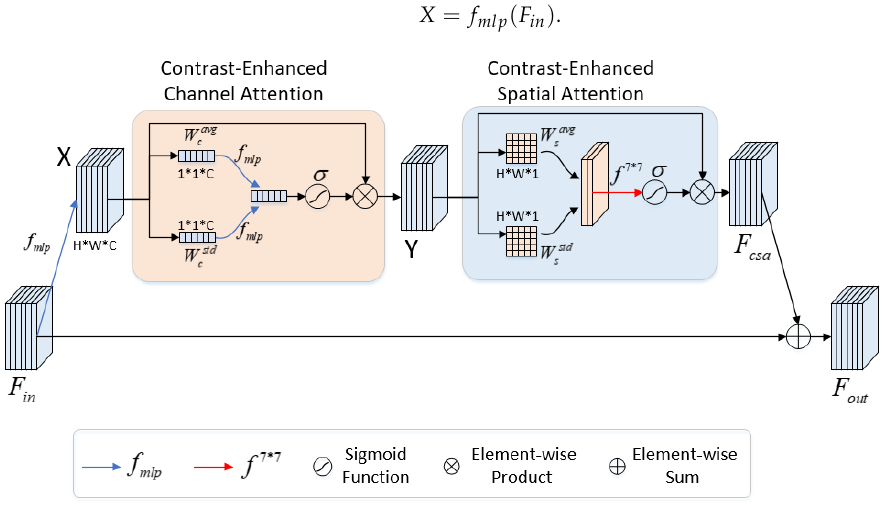
Figure 5. Contrast-enhanced residual block